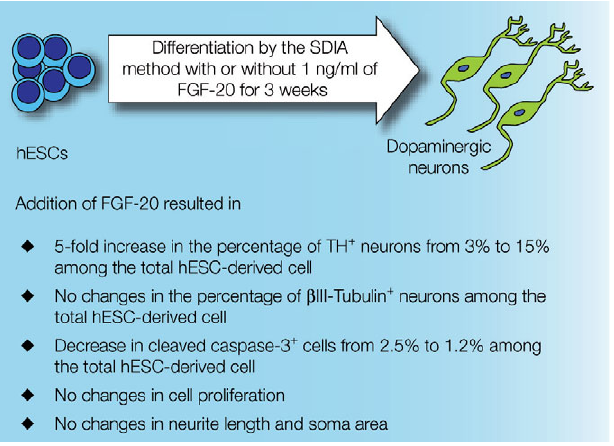
Figure 1 | Major fi ndings of the treatment with FGF-20 of hESCs cultures during dopaminergic differentiation by co-culturing with PA6 cells.